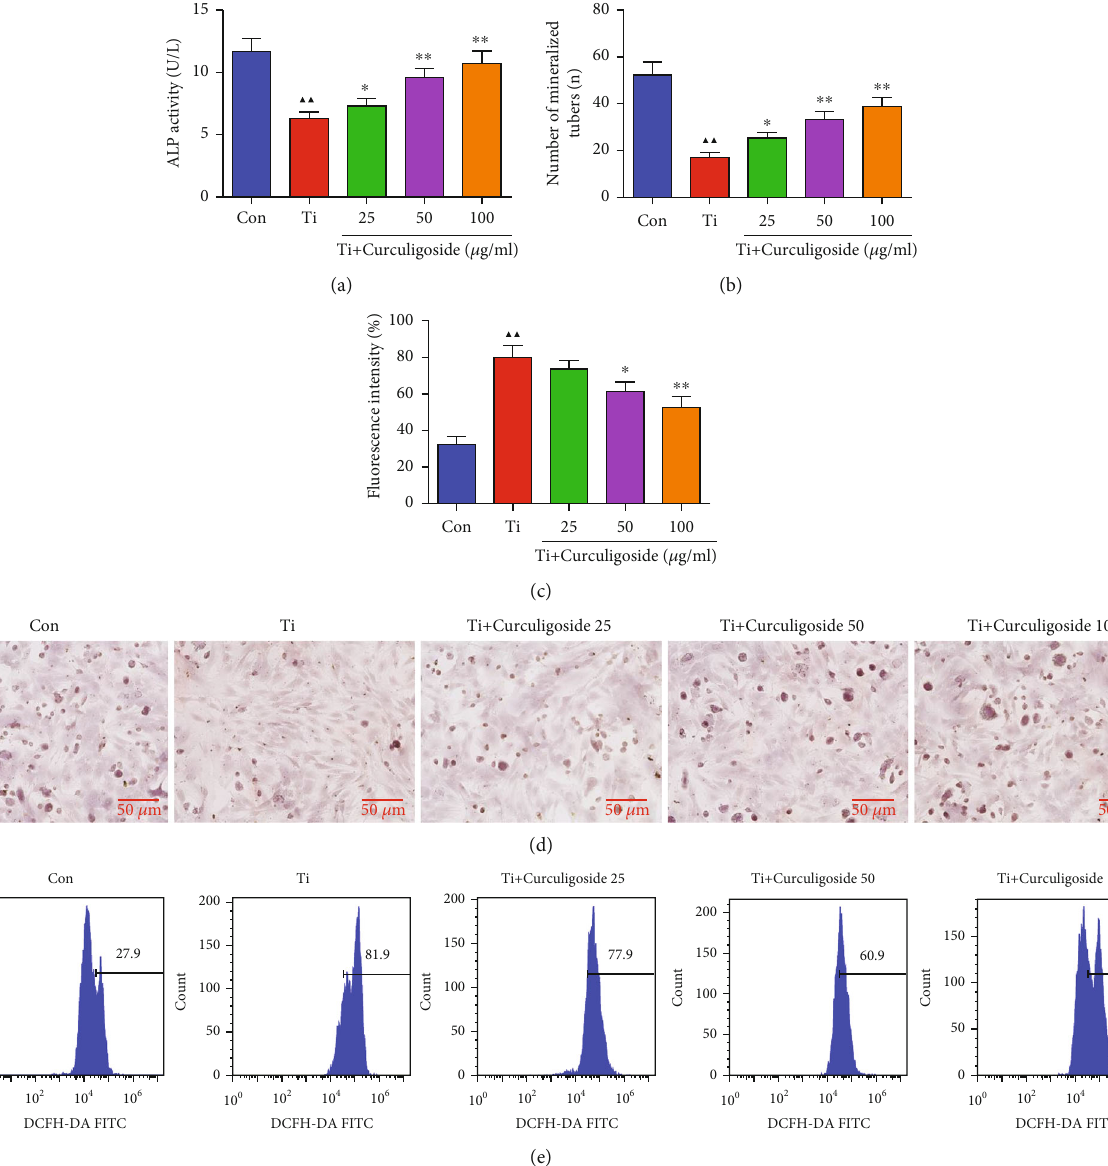
Figure 2: Curculigoside treatment alleviated Ti-induced inhibition on ALP activity, mineralization, and ROS generation in MC3T3-E1 cells. (a) MC3T3-E1 cells were detected with ALP staining, and ALP activity was quanti fi ed. (b, d) MC3T3-E1 cells were assayed by Alizarin Red staining, and the mineralization in each group cell was quanti fi ed. (c, e) Intracellular ROS level of MC3T3-E1 cells after Ti intervention and curculigoside treatment was assayed by fl ow cytometry, and ROS production in each group cell was quanti fi ed ( n = 3 ); results are represented as the mean ± SD . ▲ P < 0 : 05 , compared to the Con group; ▲▲ P < 0 : 01 , compared to the Con group; ∗ P < 0 : 05 , compared to the Ti group; ∗∗ P < 0 : 01 , compared to the Ti group. Ti: titanium particle; Con: control; ALP: alkaline